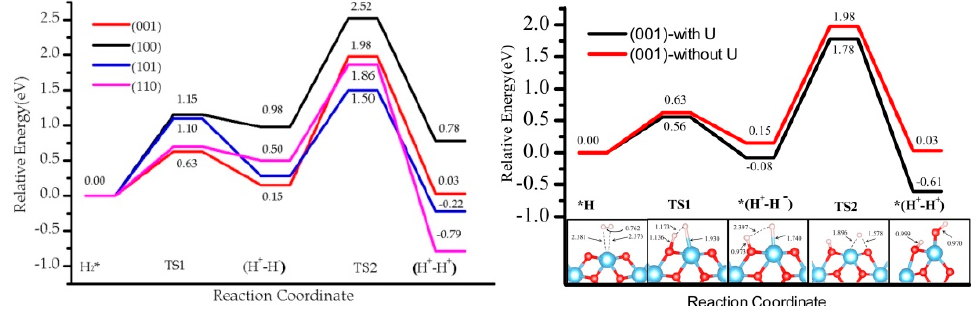
Figure 7. Comparison of energy profile on four facets without U correction ( left ). Comparison of energy profile on (001) when U is 4.0 eV and without U ( right ).